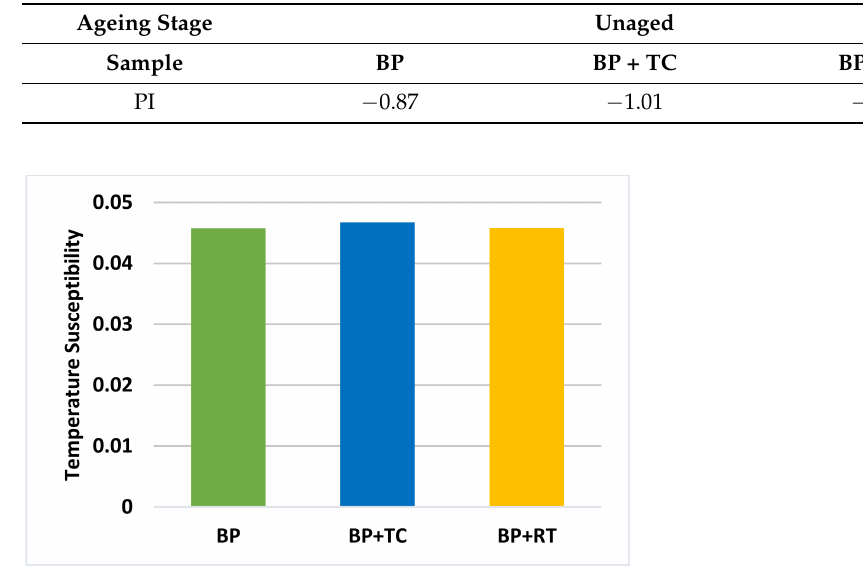
Figure 8. Temperature susceptibility of our three